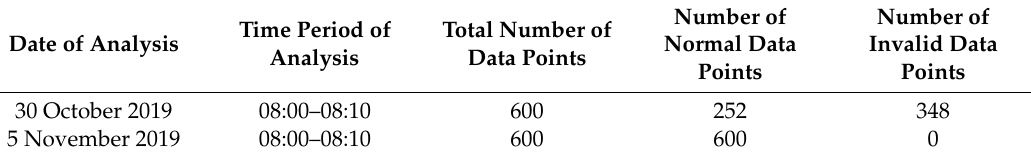
Figure 14. Monitoring data of neutral DC of transformer D on 05 November 2019. Table 4. Transformer D data validity analysis results.